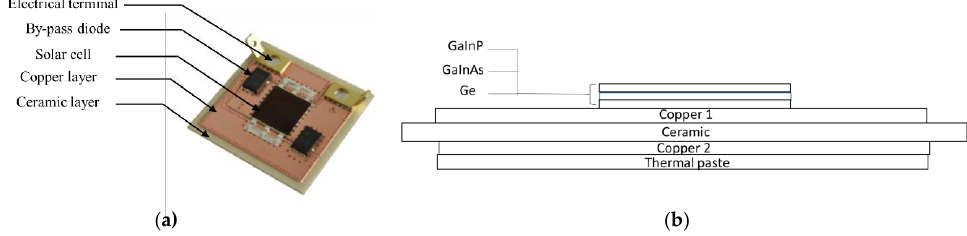
Figure 3. ( a ) Concentrating photovoltaic (CPV) assembly for Azurspace 3C44A; ( b ) CPV assembly layers.